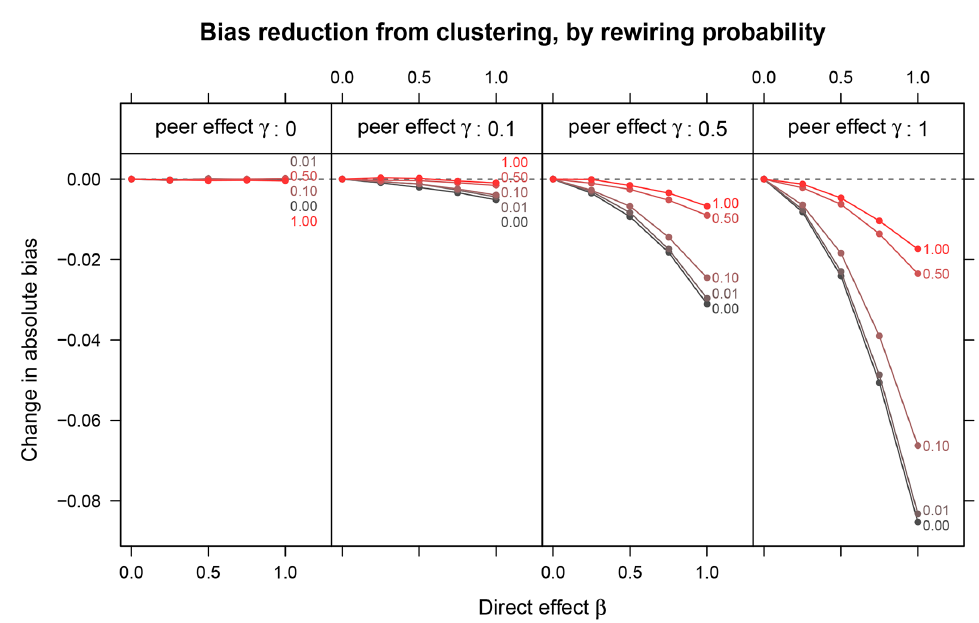
Figure 3 Change in bias due to clustered random assignment as a function of the direct effect of the treatment u , the rewiring u probability (different colors), and the strength of the peer effect u (different panels). Random assignment uu clustered in the network reduces bias, especially when peer effects are large relative to the baseline ( u = − 1 . 5 ) and when the network is more